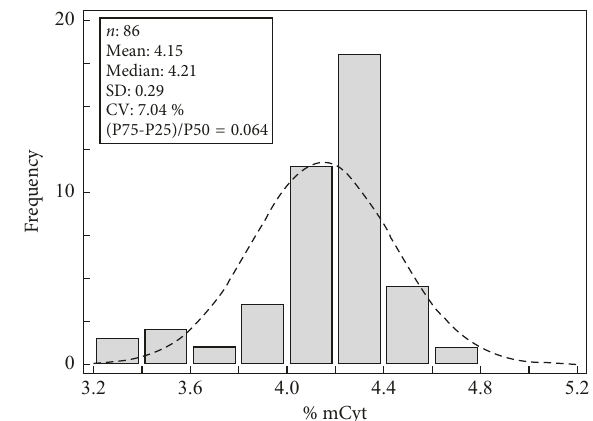
Figure 4: Distribution plots of % mCyt in 86 healthy subjects. The biological variation expressed as interindividual CV was 7.04%, and the ratio between the interquartile difference and the median was